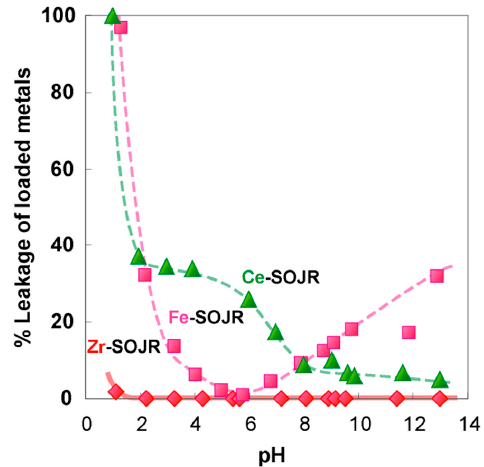
Figure 24. Leakage of the loaded metal ions from metal-loaded SOJR gels at different pH values [16]. (With permission for reuse from Indonesian Chemical Society). (With permission for reuse from Indonesian Chemical